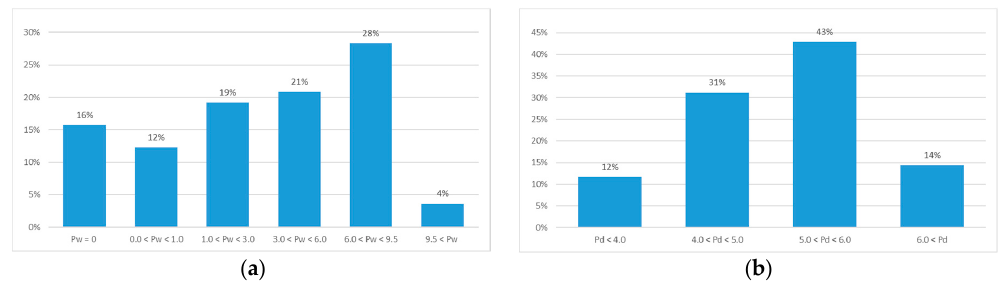
Figure 5. 2018 El Hierro power system distributions of ( a ) wind power and ( b ) power demand.